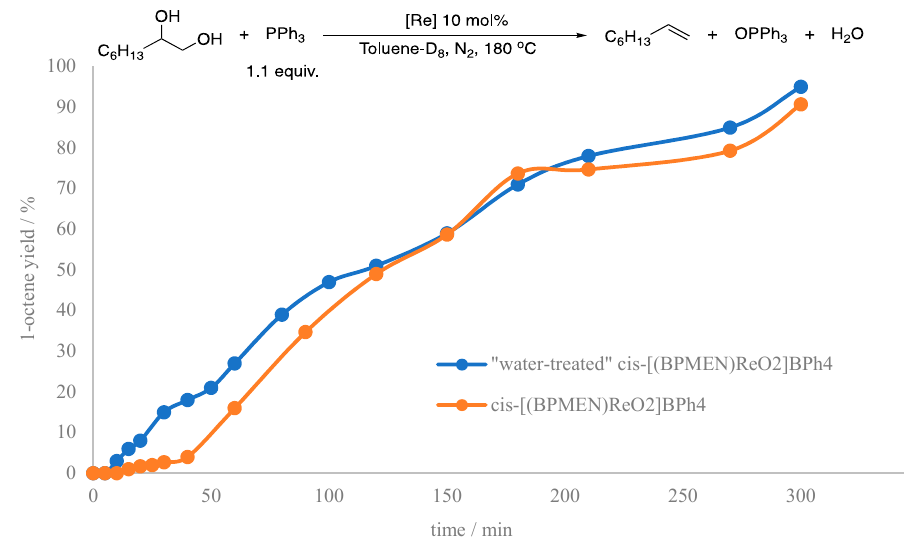
Figure 3. Time-course profile of the DODH reaction of 1,2-octanediol using cis -[(BPMEN)ReO 2 ]BPh 4 and “water-treated” cis -[(BPMEN)ReO 2 ]BPh 4 as catalyst. Reaction conditions: 1,2-octanediol (0.05